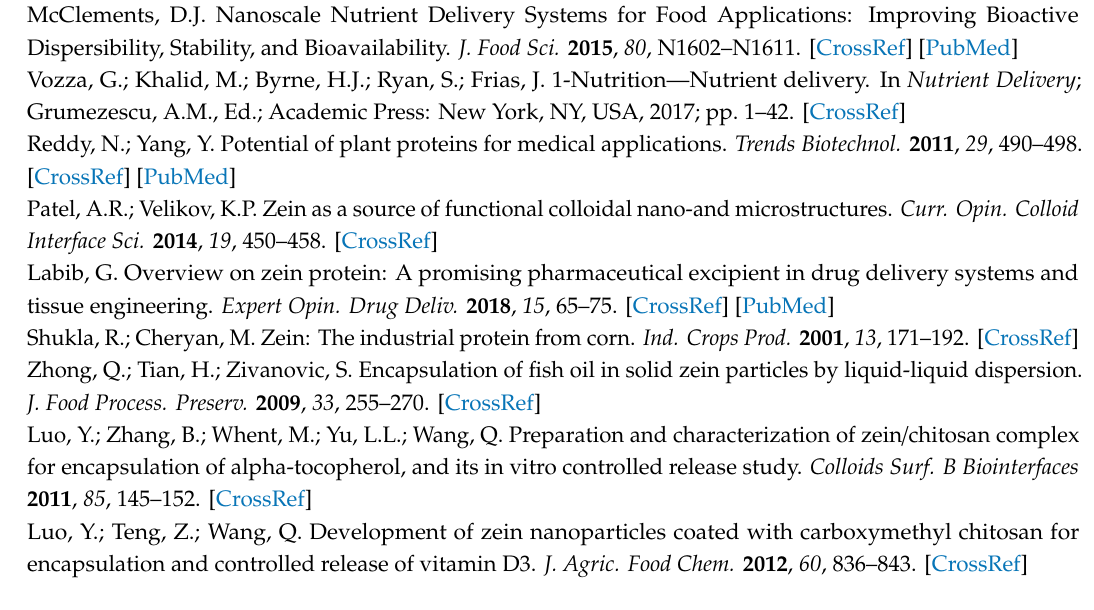
Figure S1: UV and emission spectra of hydroalcoholic solutions containing zein (20 µ g / mL) and β CD (0, 2 and 5 µ g / mL), Figure S2: FTIR spectra of zein (raw material), Figure S3: TGA thermograms of zein (raw material), Figure S4: Second run thermograms of zein, β CD and FeBIS (raw materials), Figure S5: DSC profiles (first run) of FeBIS-loaded micropowders and raw FeBIS, Table S1: Code and corresponding compositions of zein-based micropowders prepared from di ff erent pseudolatex, Table S2: Set-up of spray drying conditions for MP_Z 2 powders, Table S3: Nitrogen / protein content of zein micropowders using as reference standard zein raw material, Table S4: Glass transition temperatures (Tg) of zein-based micropowders taken in the second heating run, Table S5: Glass transition temperatures (Tg1) of raw